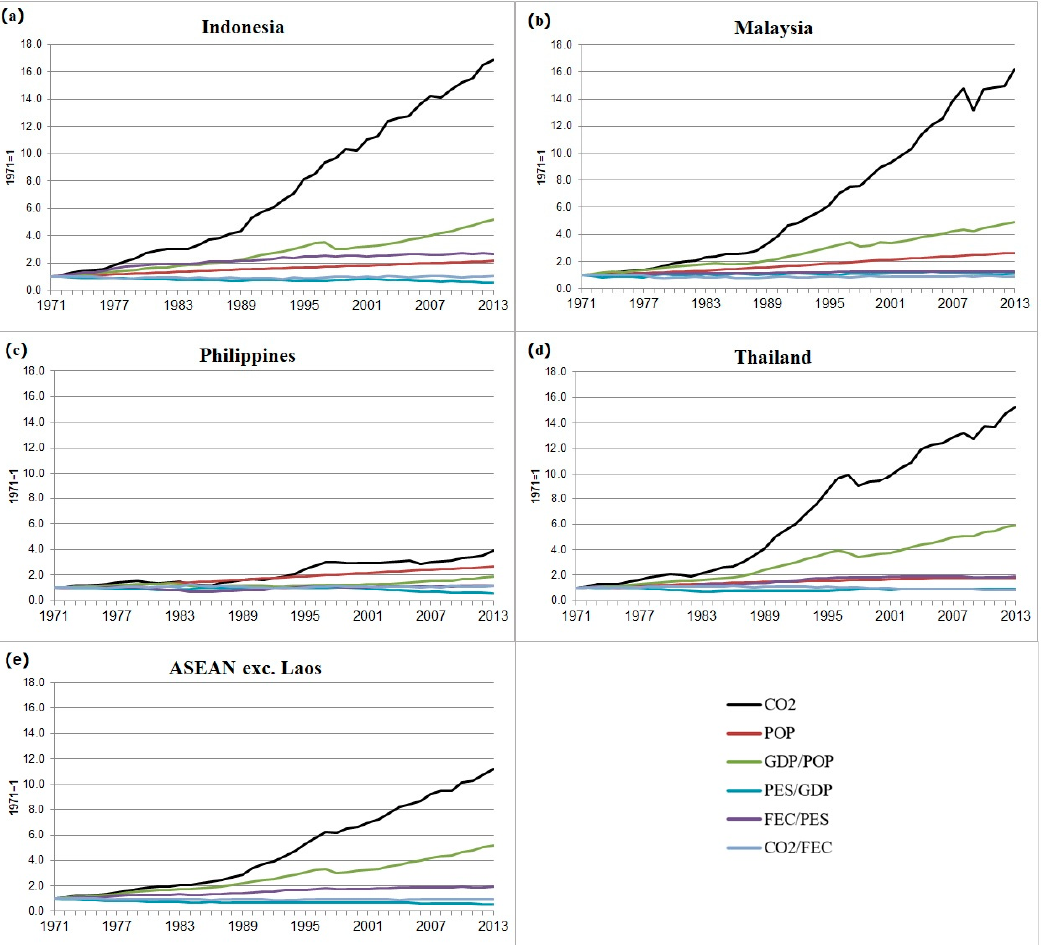
Figure 8. Trends of IPAT factors in ASEAN, Indonesia, Malaysia, Philippines and Thailand, 1971 – 2013.